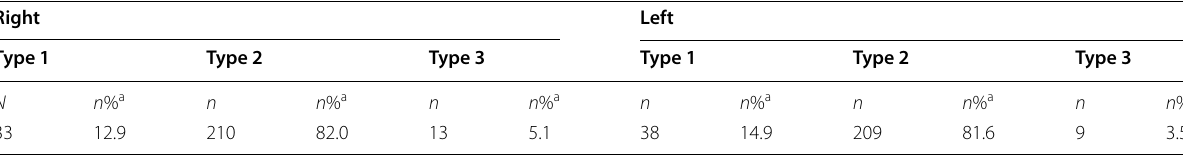
a Row percentages